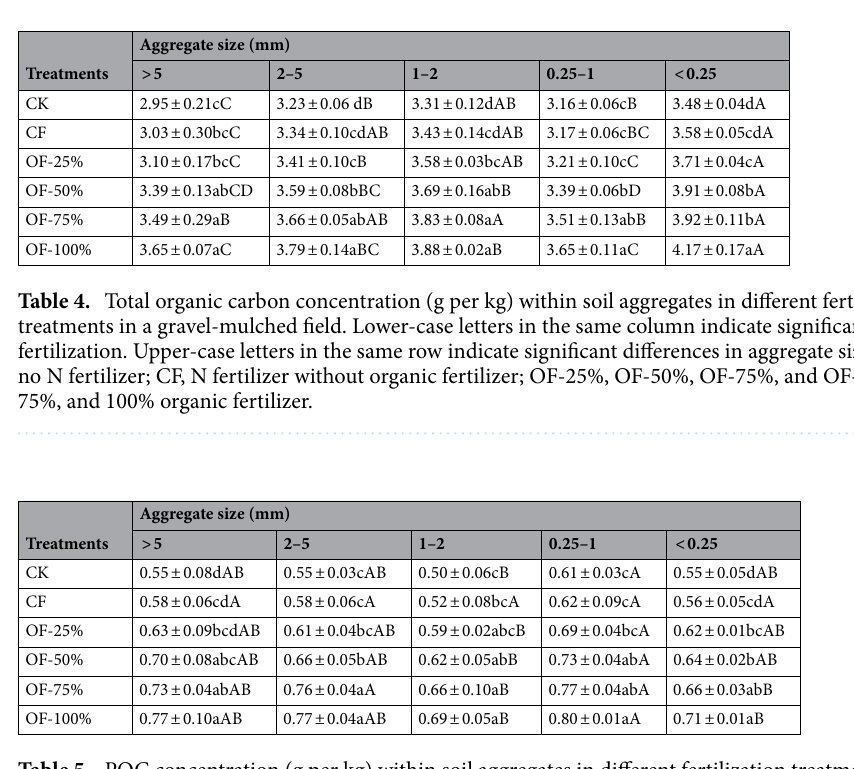
Table 5. POC concentration (g per kg) within soil aggregates in different fertilization treatments in a gravel- mulched field. Lower-case letters in the same column indicate significant differences in fertilization. Upper- case letters in the same row indicate significant differences in aggregate size ( p < 0.05). CK, no N fertilizer; CF, N fertilizer without organic fertilizer; OF-25%, OF-50%, OF-75%, and OF-100%, 25%, 50%, 75%, and 100% organic